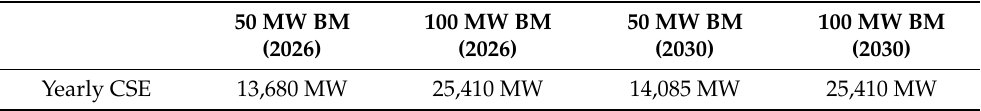
Table 4. Overlooked yearly CSE consumption in the basic